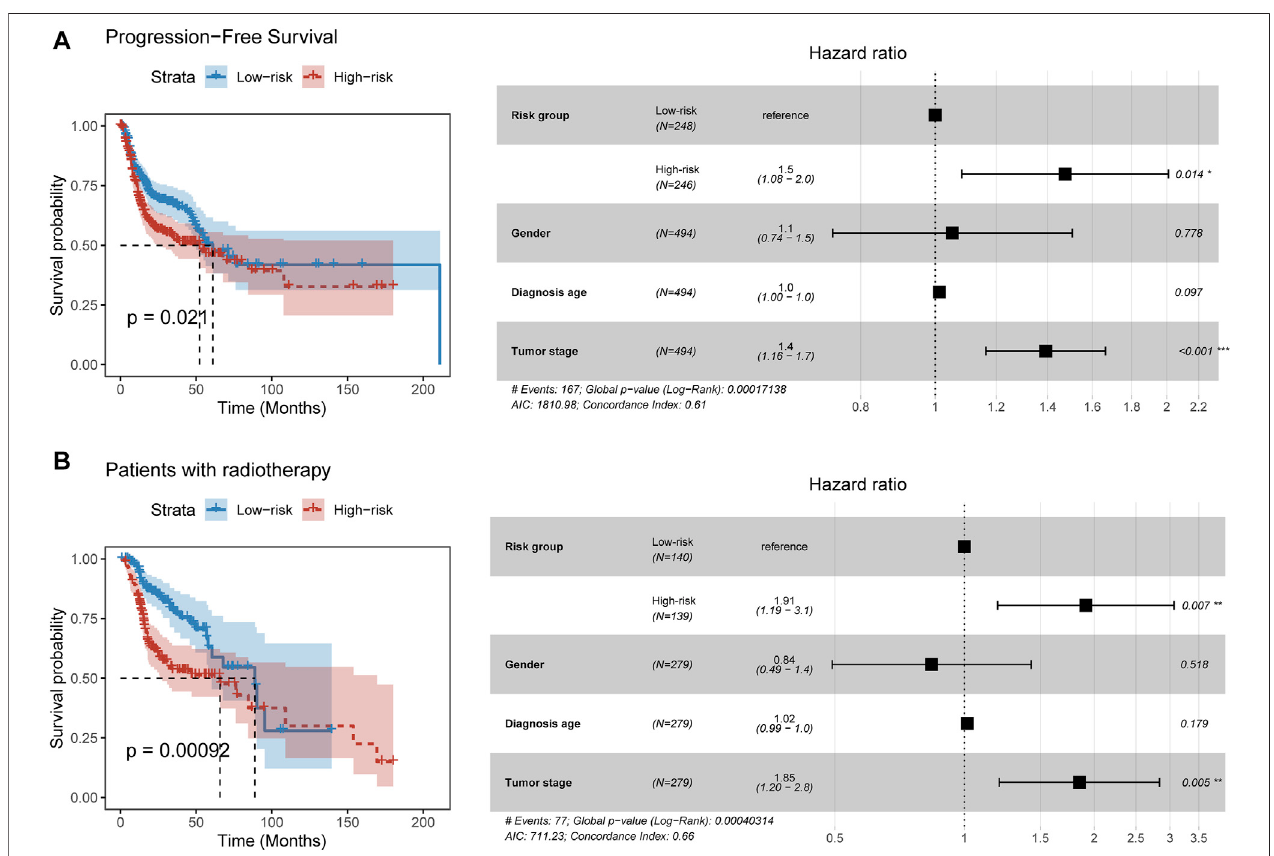
FIGURE 4 | PFLS contributes to tumor progression and radiotherapy bene fi ts. (A,B) On the left of each panel, the Kaplan – Meier curve of HNSCC cancer samples was strati fi ed by the risk group with the log-rank test p -value provided. Forest plot showing the result of multivariate Cox regression analysis for correlation between the PFLS and clinical features and the (A) progression-free or (B) overall survival was plotted on the right.